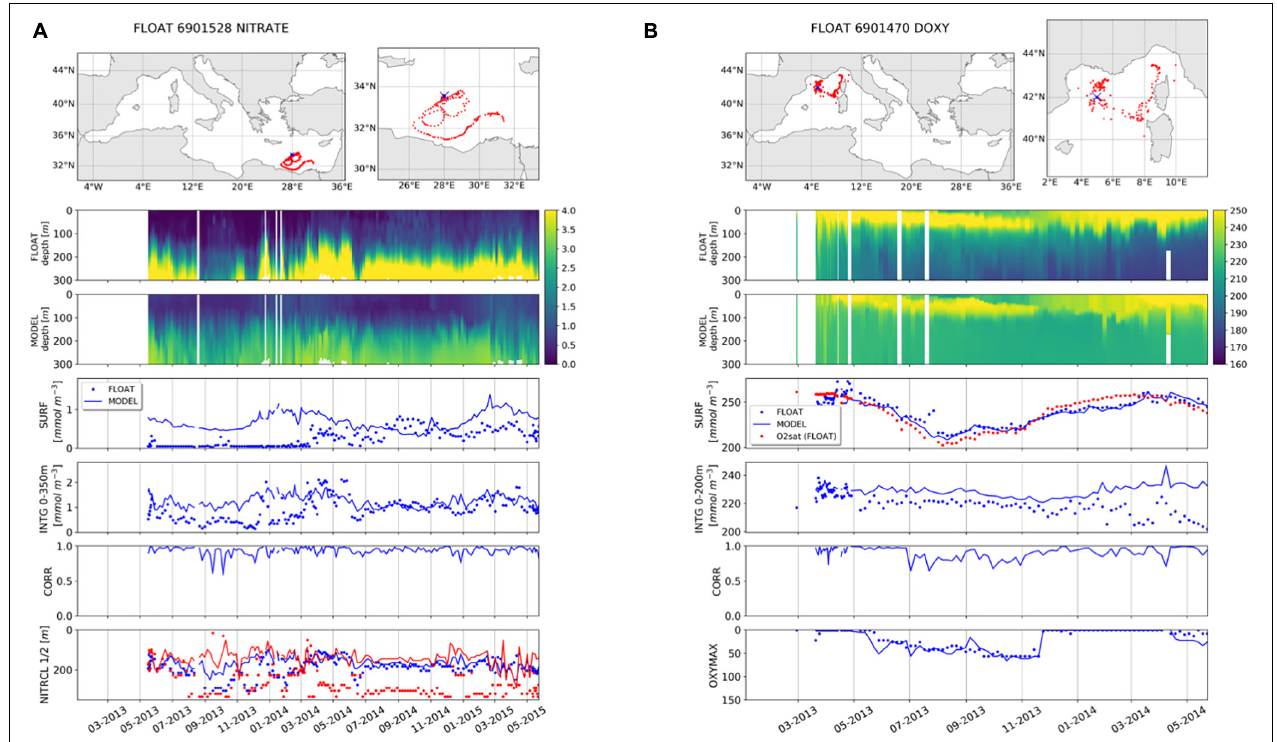
FIGURE 7 | Examples of level-3 validation for nitrate (A) and oxygen (B) based on the comparison between BGC-Argo floats and model. From top to bottom, panels are: trajectory of the BGC-Argo float (red dots) with deployment position (blue cross); Hovmöller diagrams of nitrate (mmol/m 3 ) and oxygen (mmol/m 3 ) concentration from float data (2nd row) and model outputs (3rd row) matched-up with float position for the period of float life; selected skill indexes for model (solid line) and float data (dots): surface nitrate and oxygen (SURF, 4th row; with oxygen saturation, red dots), vertical average of nitrate in the 0–350 m layer and of oxygen in the 0–200 m layer (INTG, 5th row), correlation between vertical profiles (CORR, 6th row), and depth of the nitracline and of the oxygen maximum (NITRCL, blue; OXYMAX, 7th row).